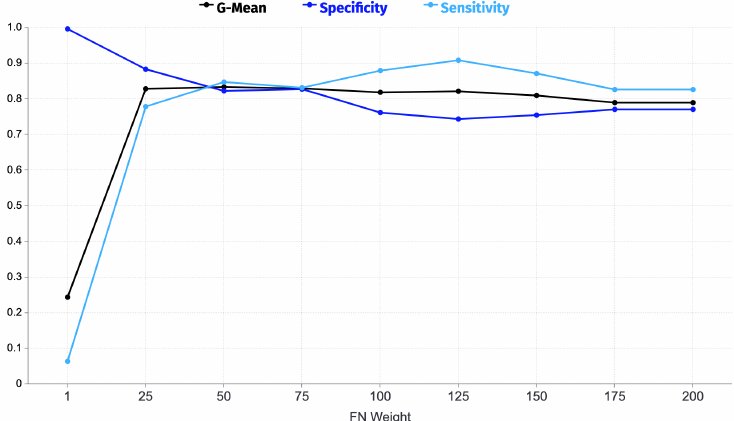
Figure 8. The effects of FN prediction weight on g-mean, specificity, and sensitivity when using the cost-sensitive MHOANN with the PSO for the dataset of Taiwanese